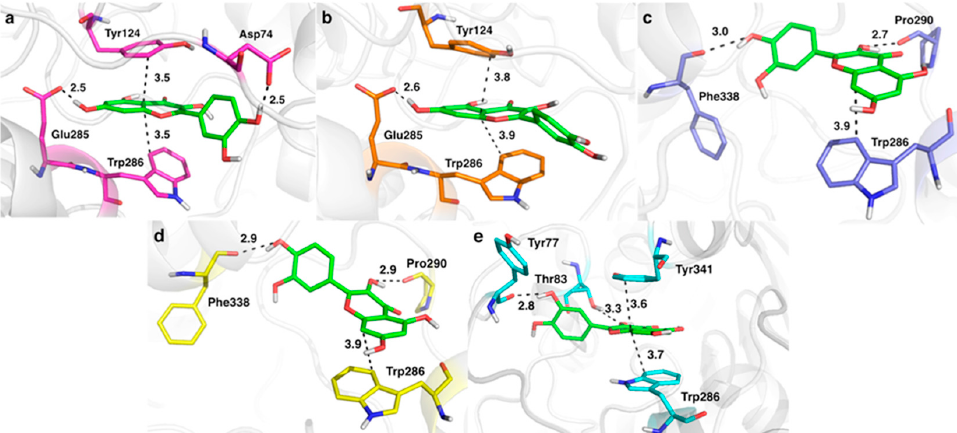
Figure 11. Five selected binding modes for quercetin (carbon atoms in green) with different human AChE systems. ( a ) 6CQU—Replica 1 (carbon atoms in magenta), ( b ) 6CQU—Replica 2 (carbon atoms in orange), ( c ) 4M0F—Replica 2 (carbon atoms in light blue), ( d ) 4M0F—Replica 3 (carbon atoms in yellow) and ( e ) 6O4X—Replica 3 (carbon atoms in cyan). Selected residues in the binding pocket are indicated as bold text. Dashed lines represent interatomic distance (values in